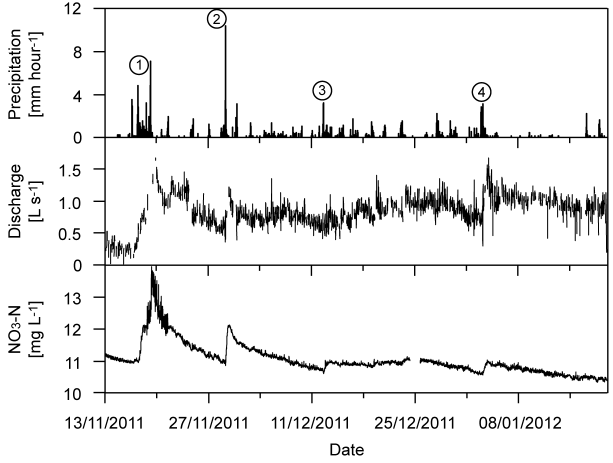
Figure 2. Observations at the study site in period (1) between 13 November 2011 and 20 January 2012. The symbols 1 (cid:13) – 4 (cid:13) indi- cate different storm events, which had a visible influence on the discharge and nitrate pattern at the